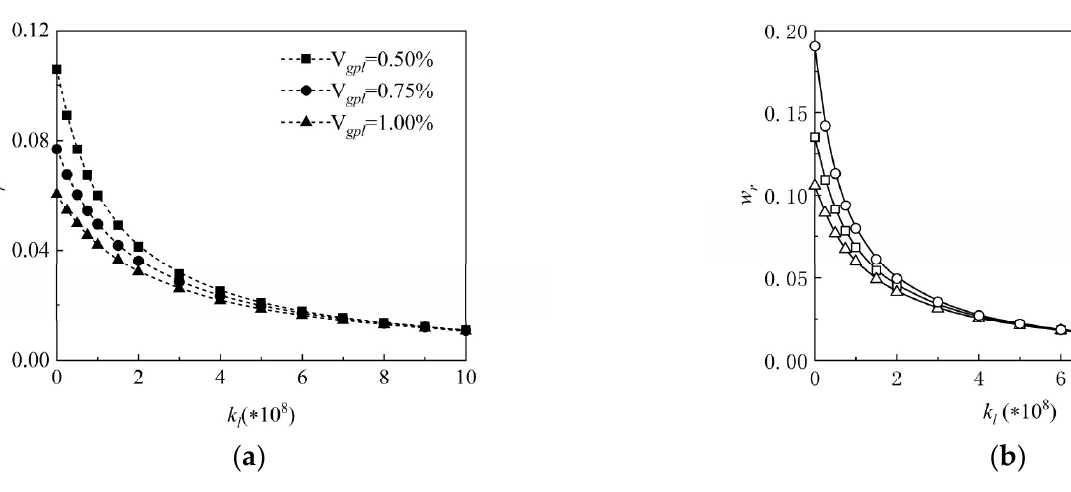
Figure 7. Variation of dimensionless central deflection along the elastic coefficient of the Winkler elastic foundation for an SSSS FG-GRP plate under different ( a ) graphene volume fractions and ( b ) graphene distribution patterns.